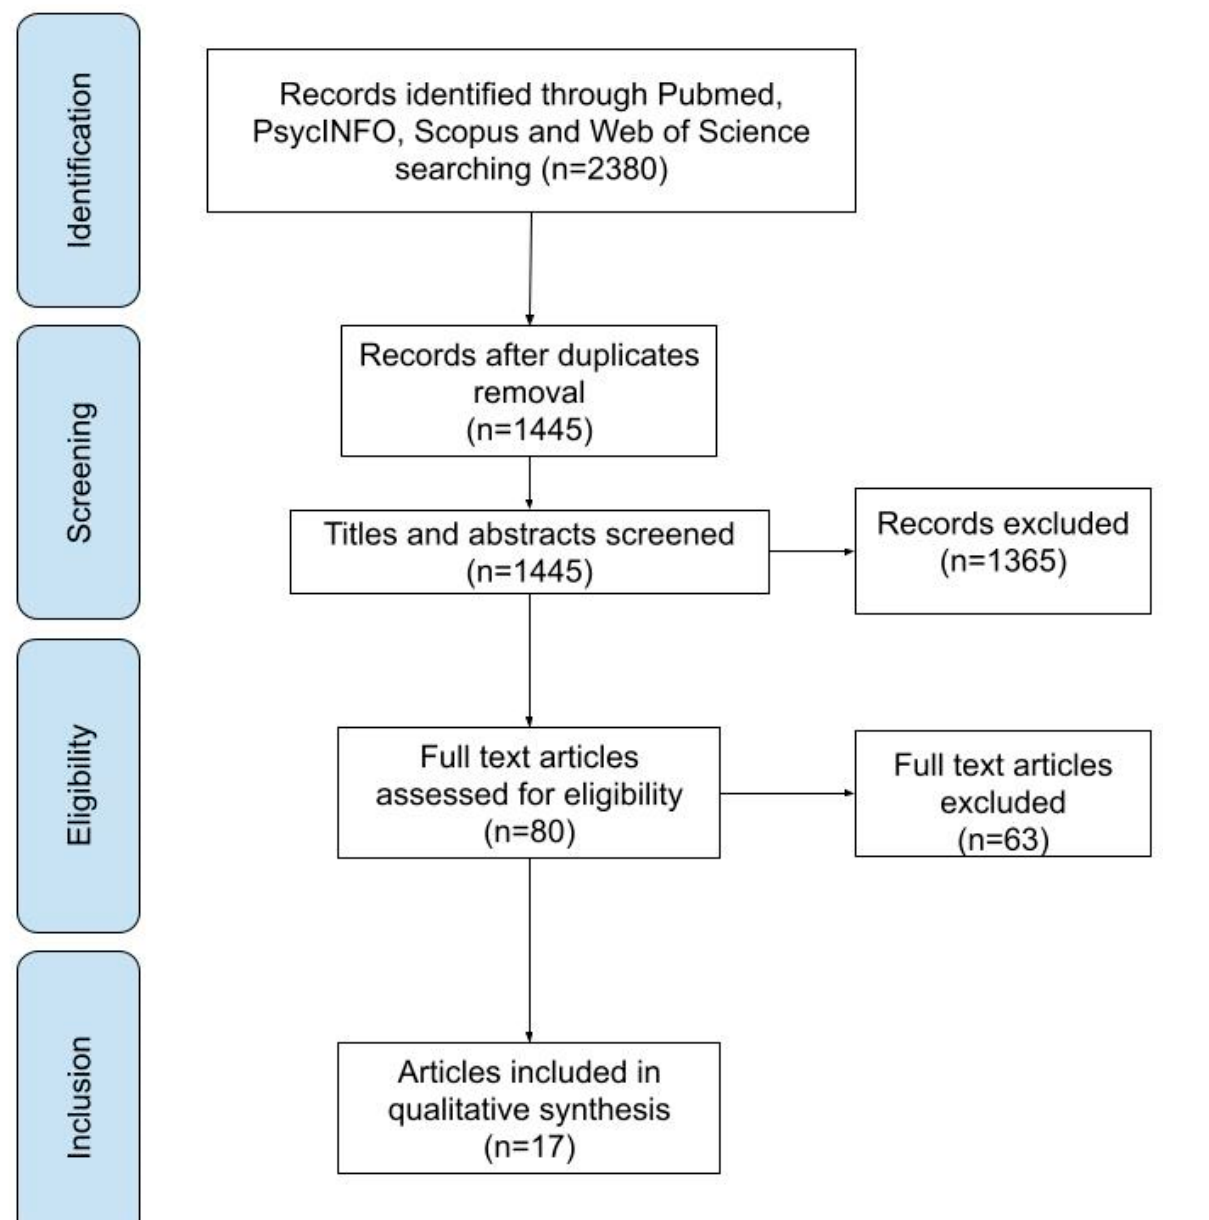
Figure 1. Flowchart of the search process.